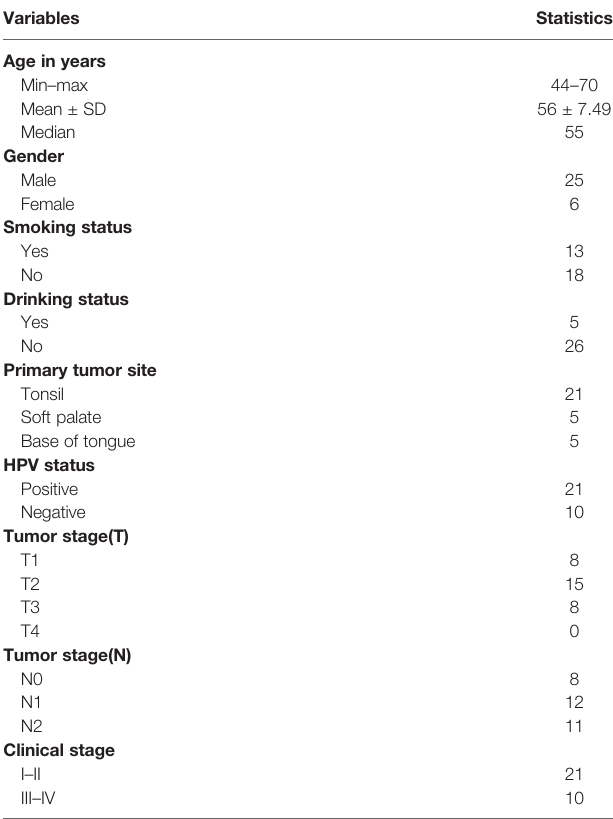
TABLE 1 | Clinical Characteristics of study